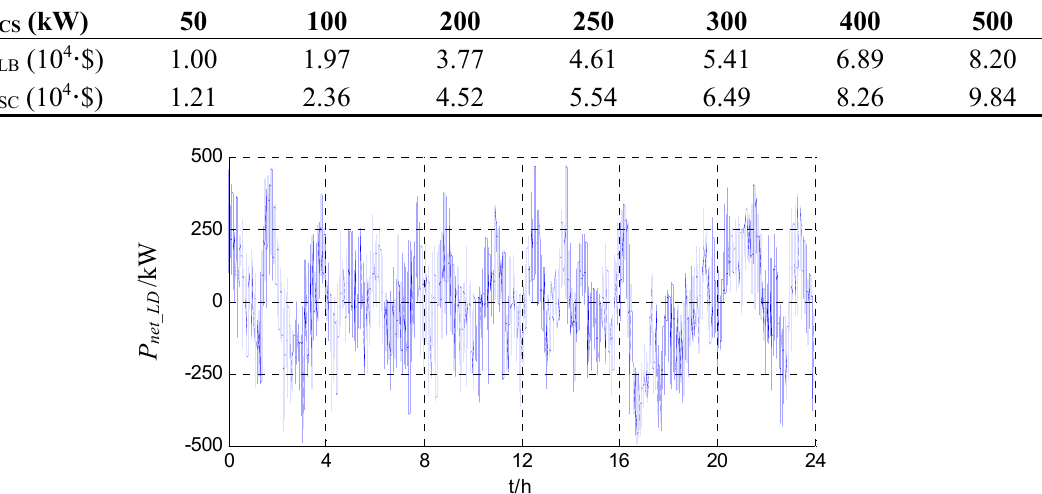
Table 2. Initial investment cost of the matching PCS for LB-ESS and SC-ESS.